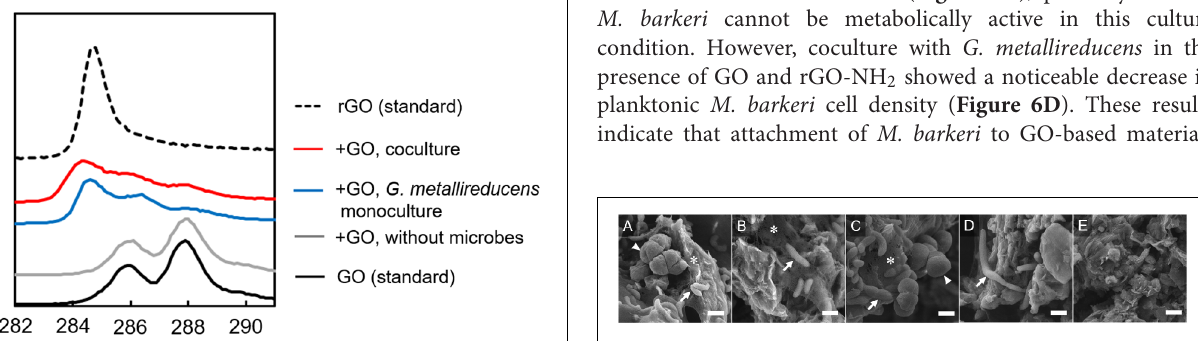
FIGURE 5 | Field-Emission Scanning Electron Microscopy images of GO-based materials surfaces. Representative images of GO-based material surface morphology of exponentially growing cocultures are shown. Arrows indicate G. metallireducens . Arrowheads indicate M. barkeri . GO (A) ; rGO (B) ; rGO-NH 2 (C) ; rGO-ODA (D) ; GO before cultivation (E) . Bars, 1 µ m. ∗ Exopolysaccharide-like